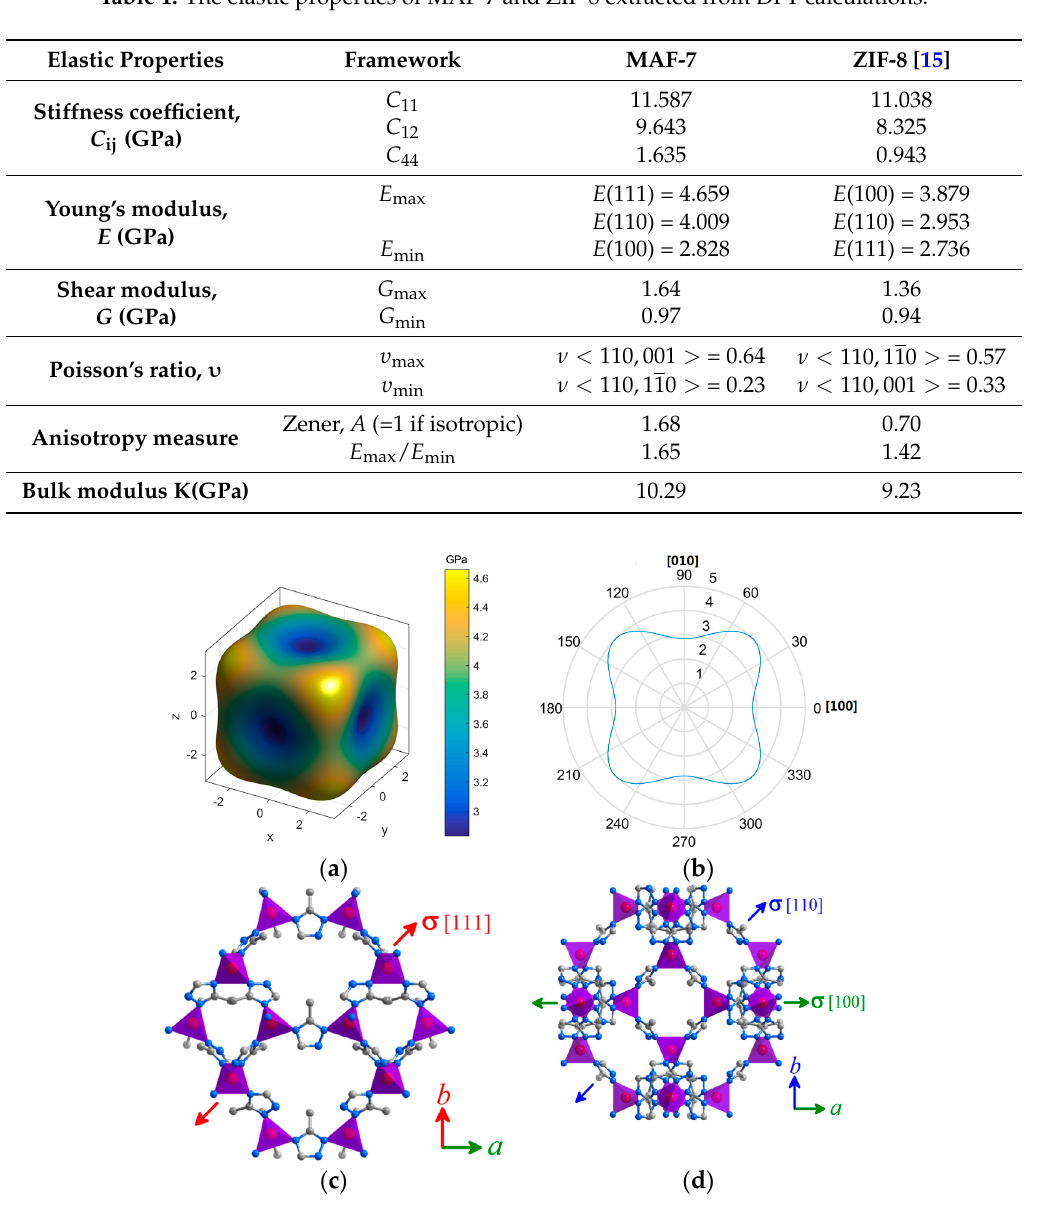
Table 1. The elastic properties of MAF-7 and ZIF-8 extracted from DFT calculations.